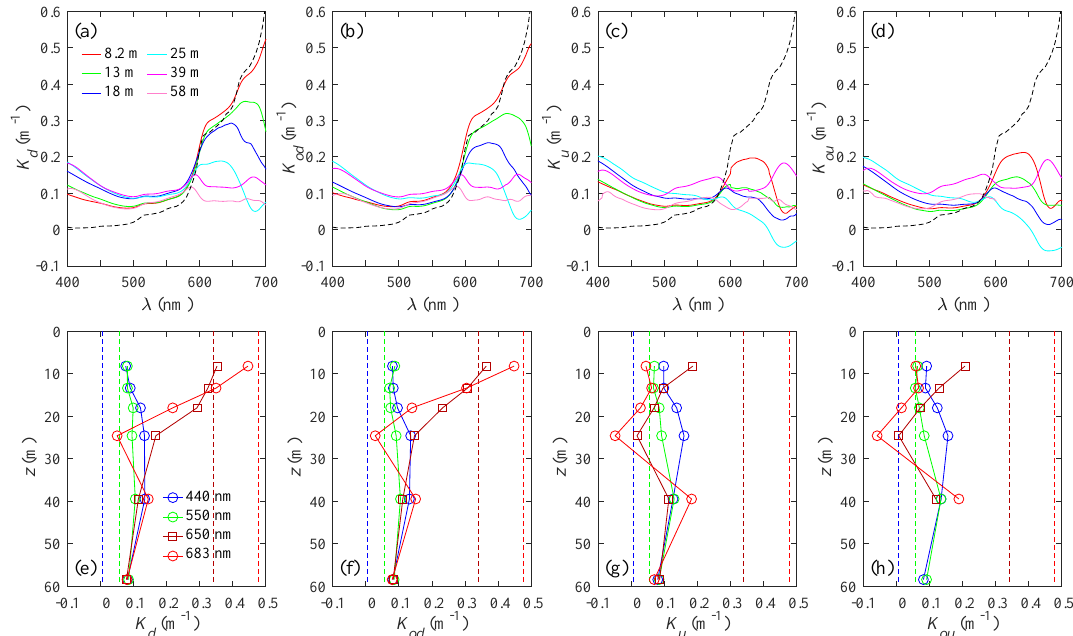
Figure 6. Spectra and vertical profiles of diffuse attenuation coefficients, K d ( a , e ), K od ( b , f ), K u ( c , g ), and K ou ( d , h ), derived from the irradiance quartet for Guaymas Basin in Figure 4. In panels ( a – d ) different colors represent the mid-point depths of the layers within which the K coefficients were determined as indicated in panel ( a ). Dashed lines represent the spectrum of pure water absorption coefficient, which is a theoretical minimum of K for a hypothetical case when no inelastic processes and true emission sources are present. In ( e – h ) different colors and symbols represent the light wavelengths as indicated in panel ( e ) and dashed lines represent pure water absorption at respective wavelengths.